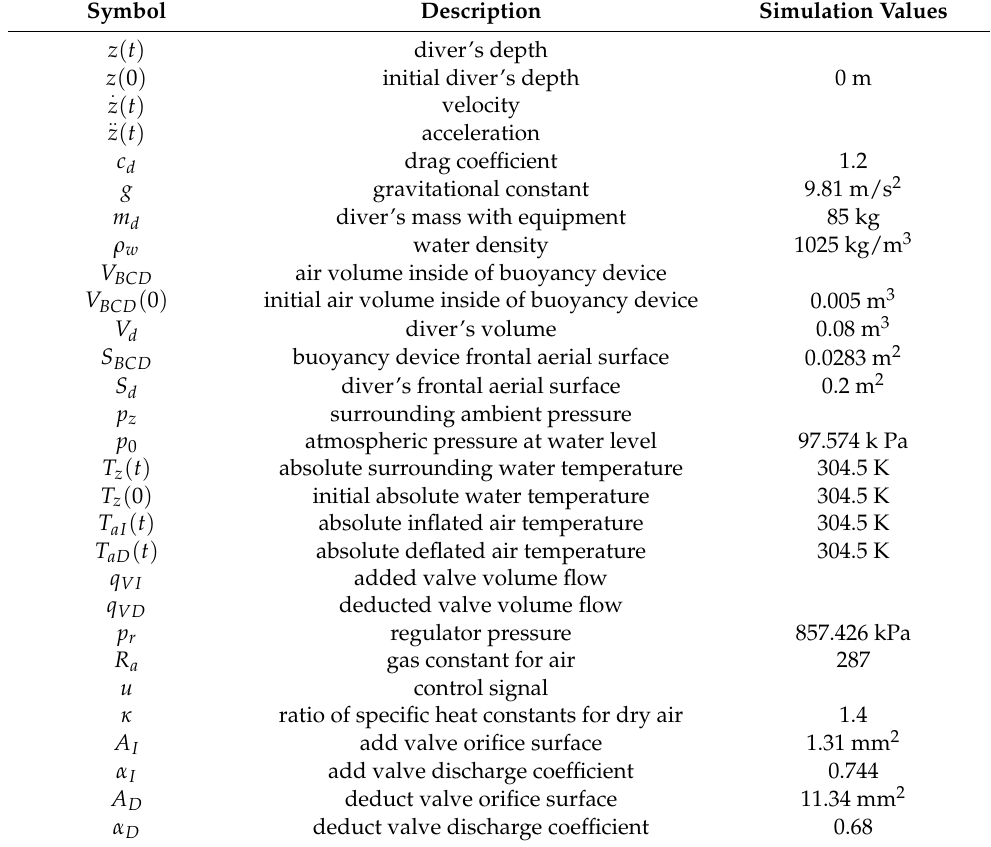
Table A1. Summary of symbolic parameters and simulation values.